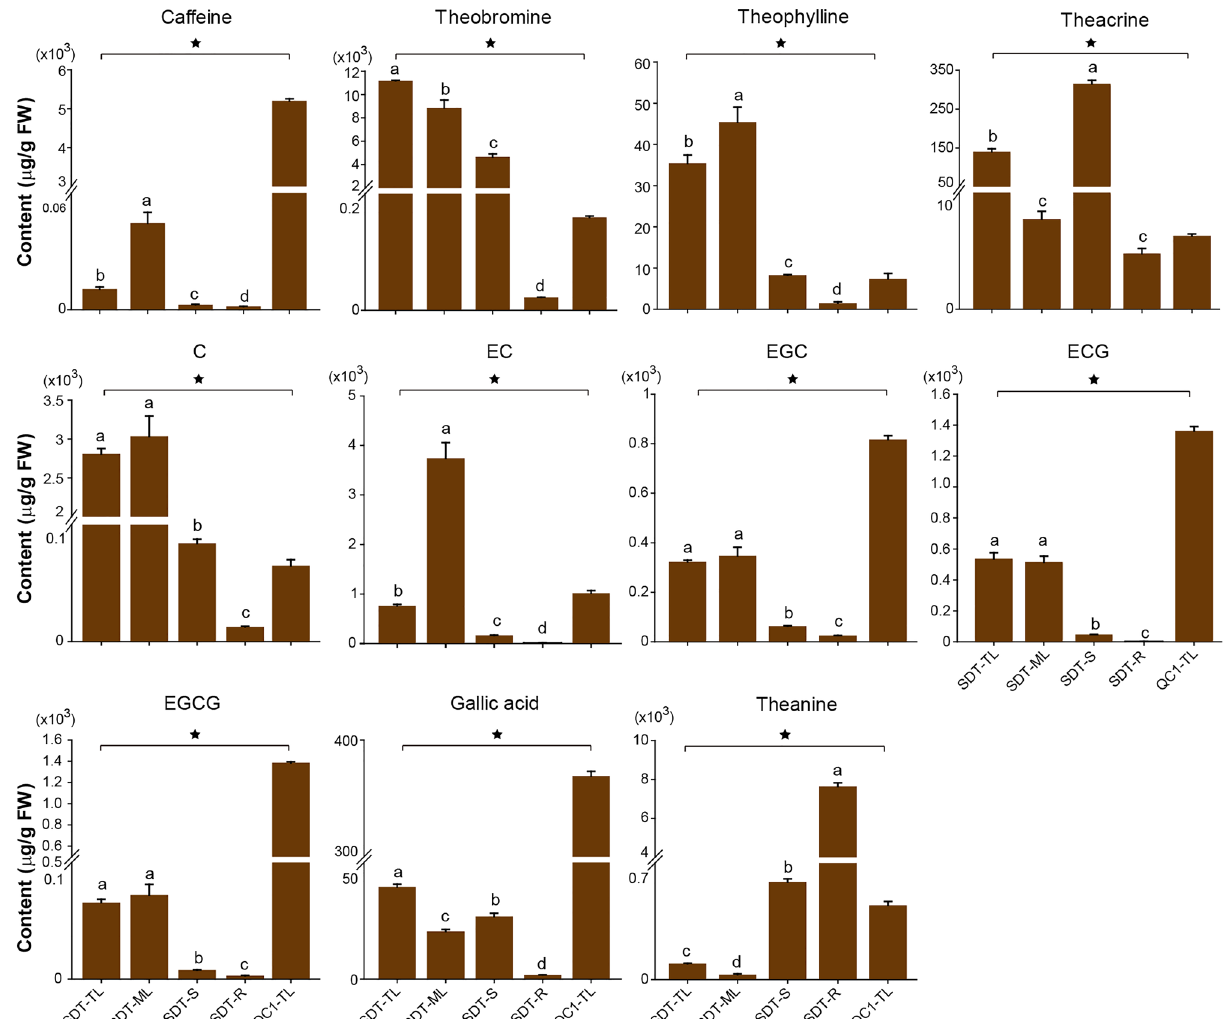
Figure 2. Contents of purine alkaloids, catechins and theanine in tea samples. Data represent mean ± SD of three biological replicates. The different lowercase letters on the bar graph indicate significant differences at p <